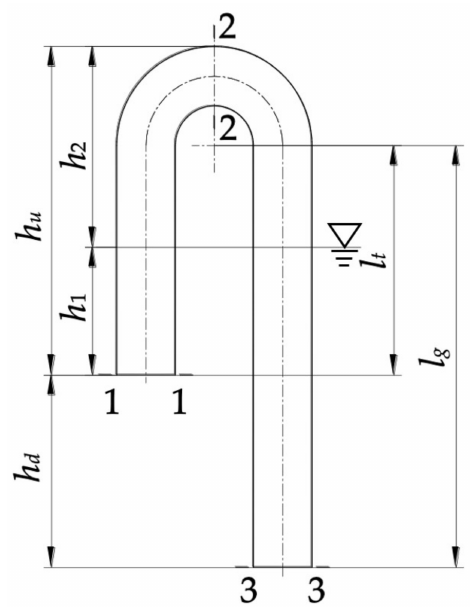
Figure 6. Height marks and cross-sections marked in a simplified siphon pipe.